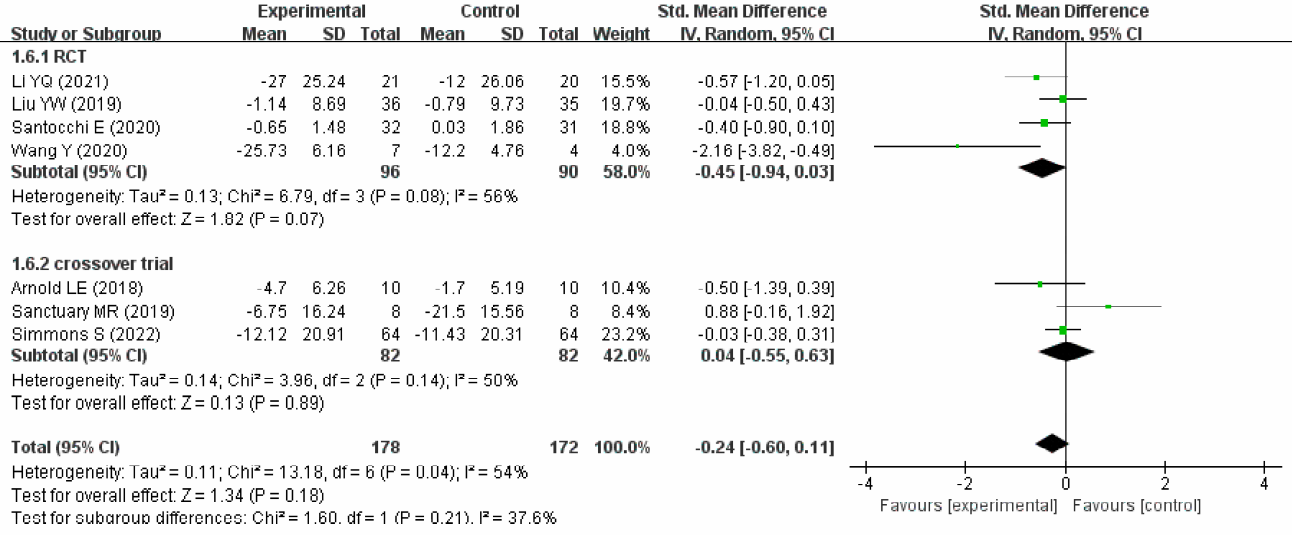
Figure 6. Forest plot for the subgroup analysis according to study type [23,25,27–30,32].